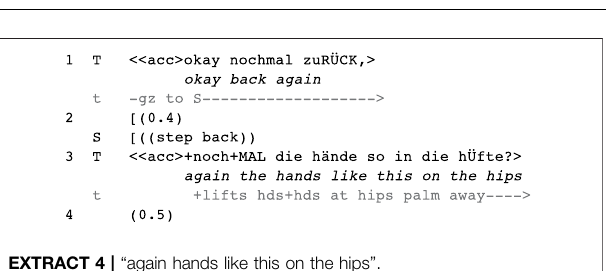
FIGURE 8 | Consistent look at the students, absence of gaze projection.